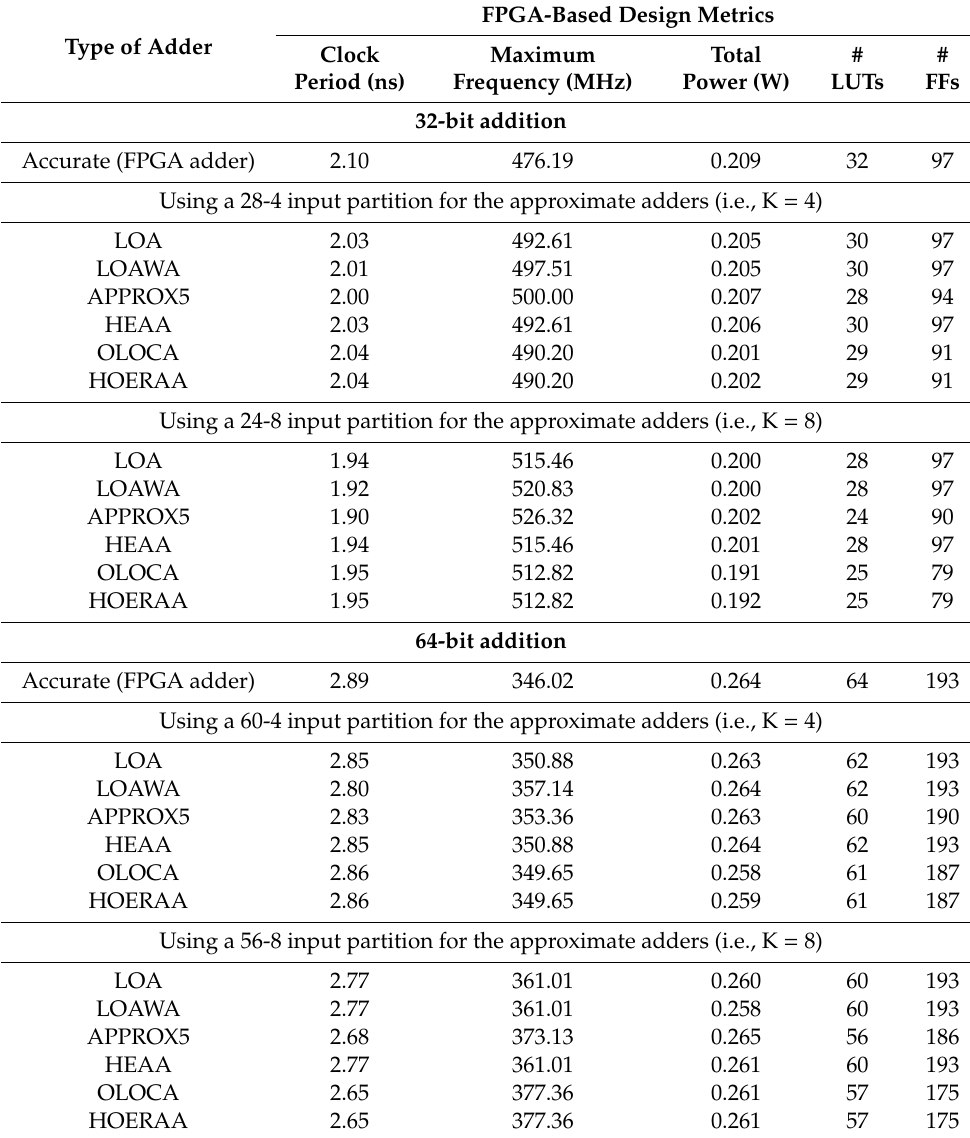
Table 1. Field programmable gate array (FPGA)-based implementation results (post-place and route) for 32- and 64-bit accurate and approximate adders using Xilinx Vivado 2018.3, targeting an Artix-7 FPGA. LUT, look-up tables; FF, flip-flops; LOA, lower-part OR adder; LOAWA, LOA without the 2-input AND function; HEAA, hardware-e ffi cient approximate adder; OLOCA, optimized version of LOA; HOERAA, hardware optimized and error reduced approximate